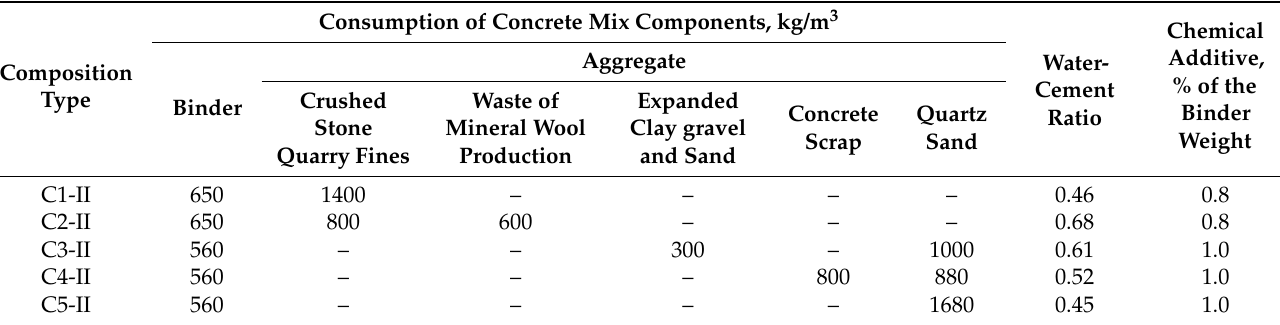
Table 3. Compositions of concrete for the second line of